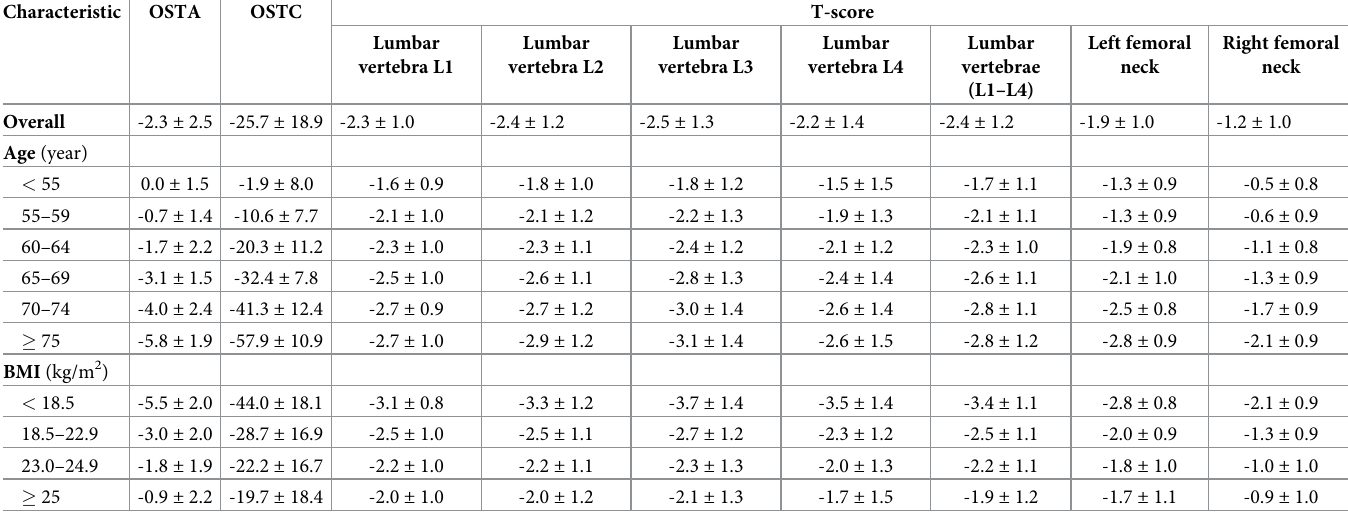
BMI: Body mass index; OSTA: Osteoporosis self-assessment tool for Asians; OSTC: Osteoporosis screening tool for Chinese. Data presented as mean ±